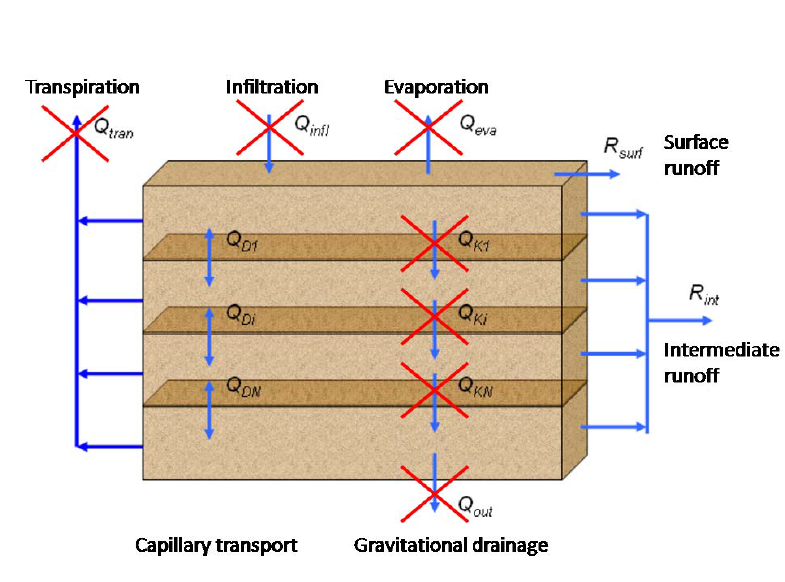
Figure 9. Representation of the moisture fluxes between the different soil layers and the external environment. During the sensitivity test discussed in Section 5.2, transpiration evaporation, infiltration and gravitational drainage have been set to zero.